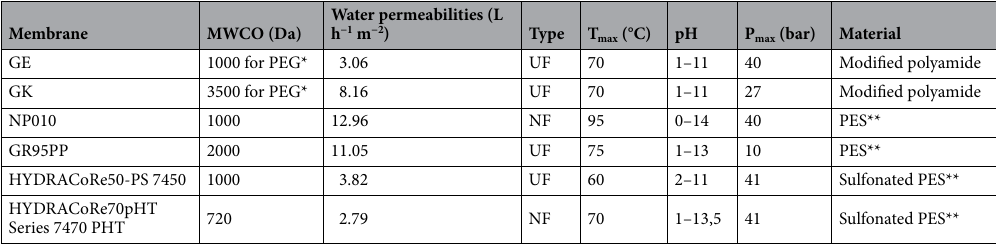
Table 4. Overview of the selected membranes and their specifications. *PEG: Poly(ethylene glycol), **PES: Polyethersulfone.